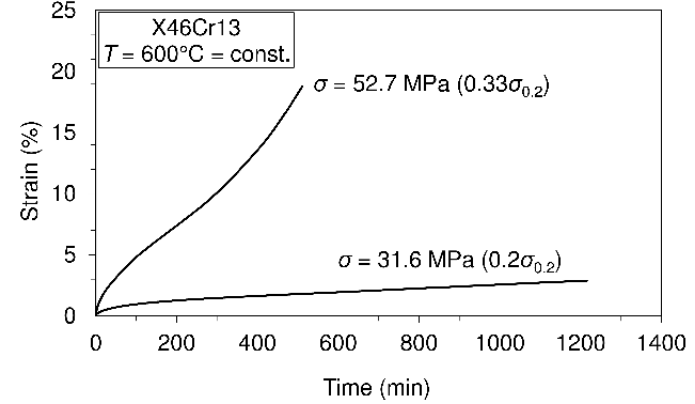
Figure 8. Short-time creep tests of steel X46Cr13 at the temperature of 600 °C.